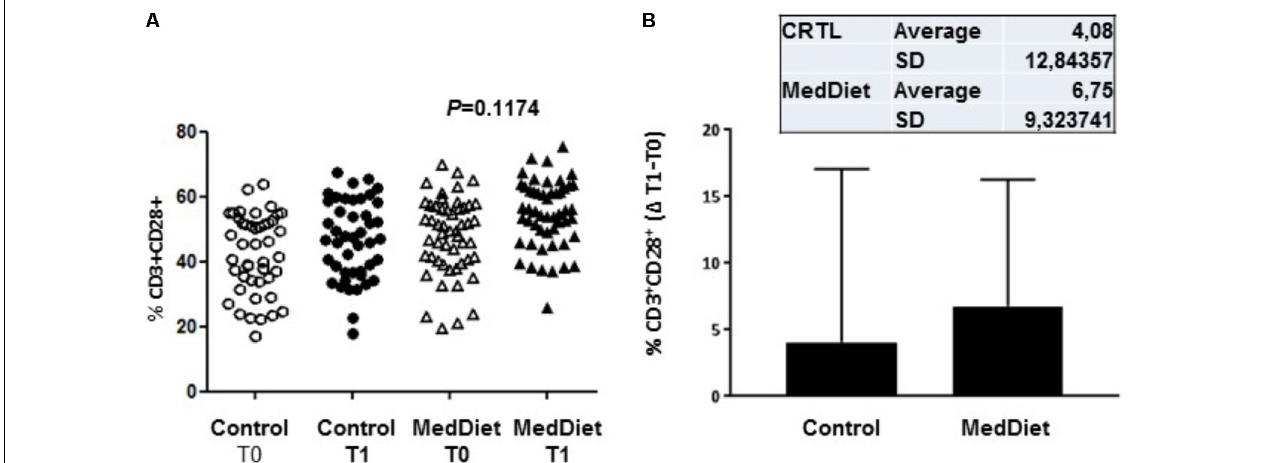
FIGURE 6 | Expression of co-stimulatory molecules on freshly isolated PBMC. PBMCs were stained with CD3 and CD28 antibodies. All individual values for both the MedDiet and control group at T0 and T1 are shown (A) . A trend toward higher frequency of CD3 + CD28 + cells in the MedDiet intervention group was seen in both genders (OR 2.19, 95%CI 0.92–5.21, P = 0.1174). Also, changes ( (cid:49) ) of parameter values in MedDiet and control diet at baseline and after 1-year of intervention were determined (mean ± SD in inset) and compared (B) .